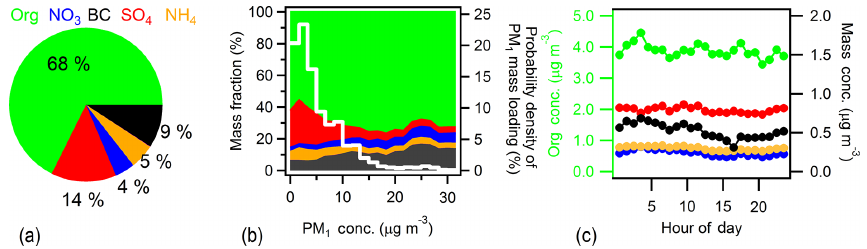
Figure 3. The (a) average chemical composition of the whole campaign, and (b) the mass fractions of PM 1 species as a function of PM 1 mass loading (left axis) with the white line representing the probability density of PM 1 mass loadings (right axis). (c) The diel cycle of different species with the left axis for organics and the right axis for the rest of the